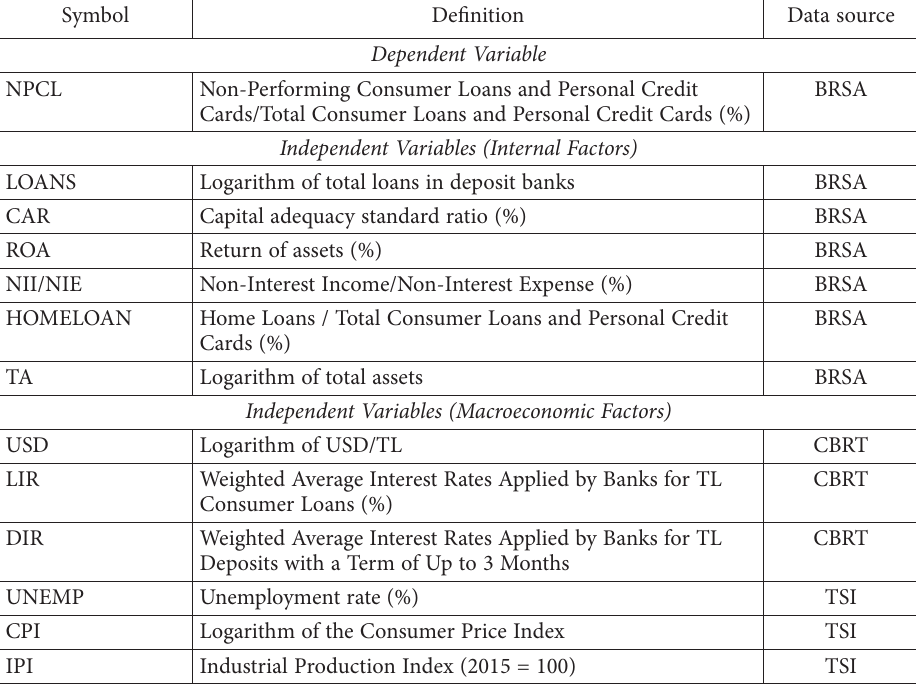
Table 2. Variables used in the study (source: compiled by the author) Symbol Definition Data